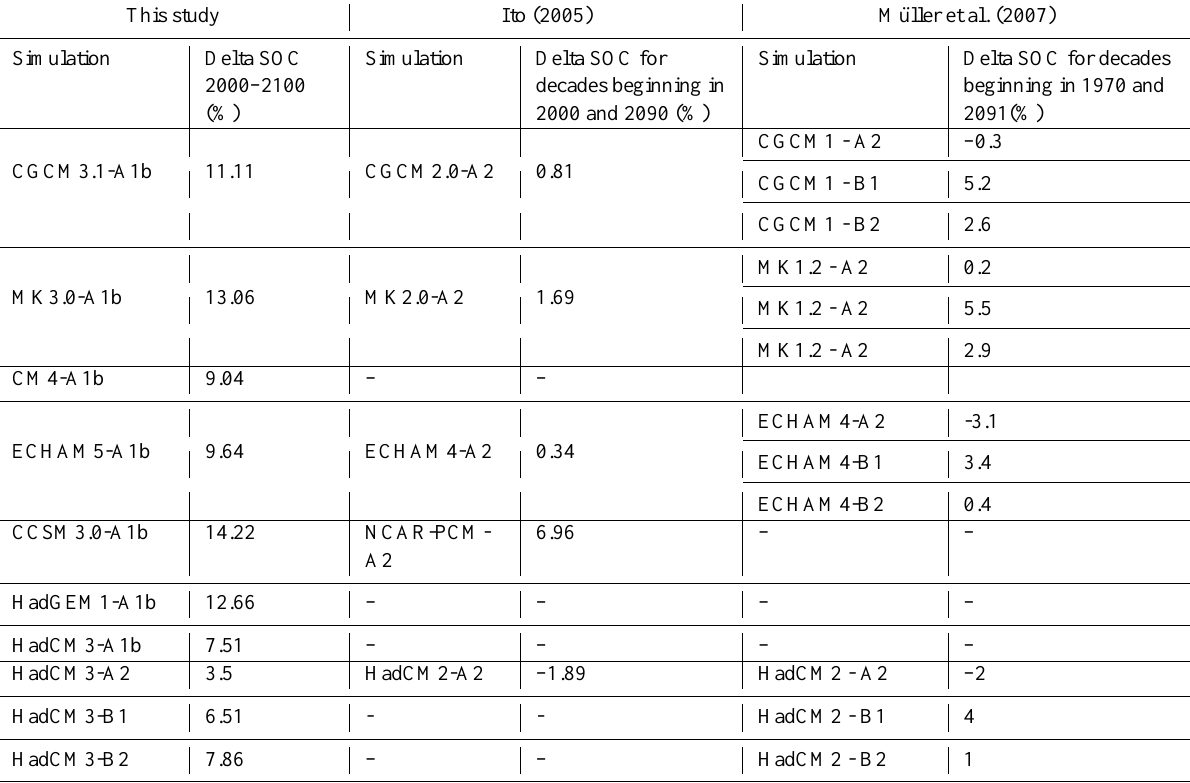
Table 5. Simulated changes of global SOC stocks in the 21st century in % for the ten simulations of our study and the comparable studies of Ito (2005) and M¨uller et al. (2007). Please note that, except the simulations with the Hadley Centre AOGCM, the simulations differ in the driving anthropogenic emission scenario: A1b for our study and A2 for the study of Ito (2005) and A2, B1 and B2 for the study of M¨uller et al.